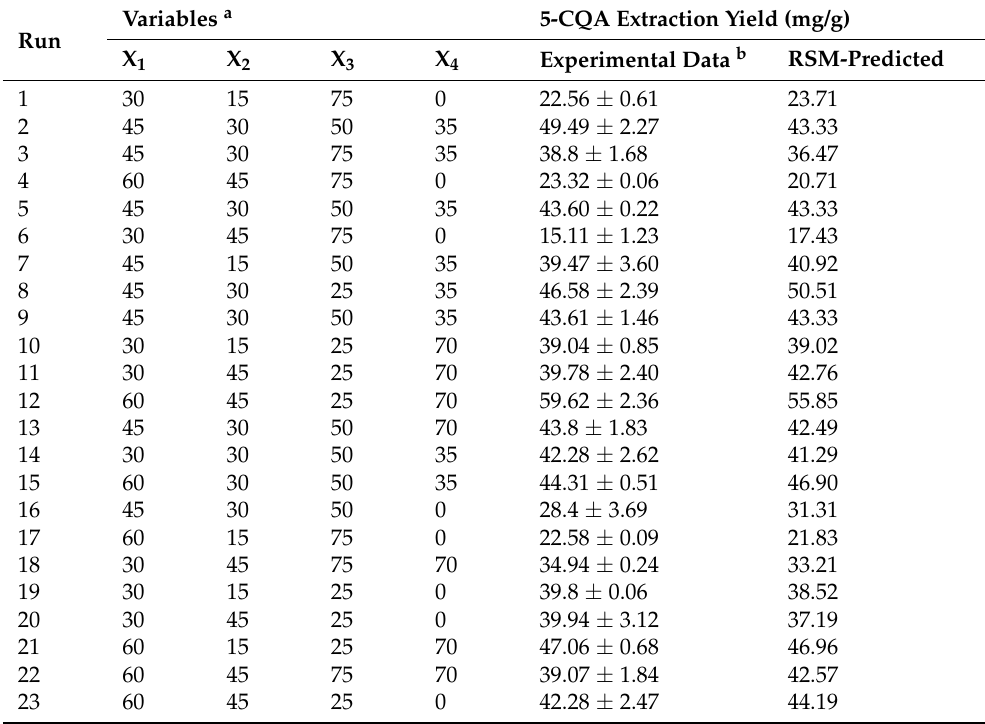
Table 1. Central composite design matrix and results obtained in the study of 5-CQA extraction yield from green-coffee by-product.